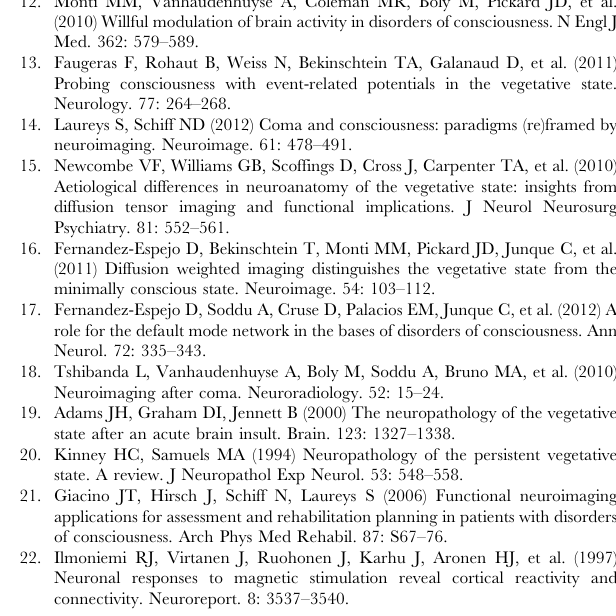
Figure S1 The EEG power spectra at the Cz and Pz electrodes. The FFT spectral analysis does not show statistically significant differences between the minimally conscious state (MCS) and vegetative state (VS) patients (all Fs smaller than 2.19, P . 0.79). The red line represents the grand average of the EEG power spectra of the MCS patients, and the black line refers to the VS patients. The dotted lines delineate the frequency bands considered in the